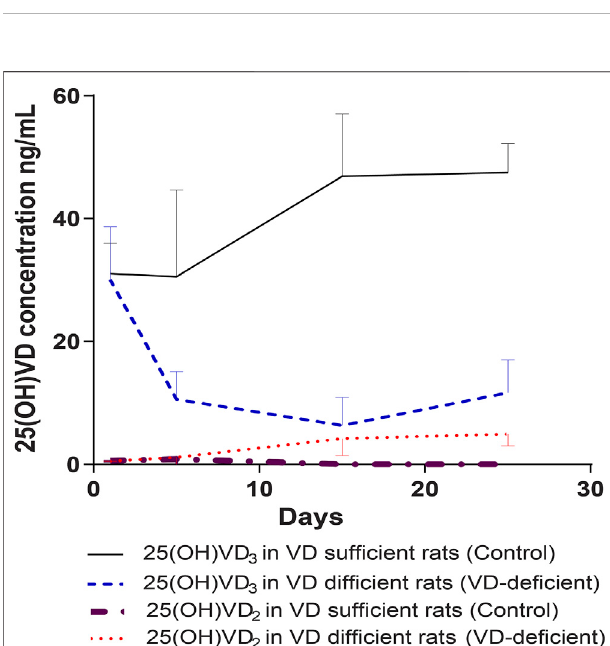
FIGURE 2 | Dynamic monitoring of plasma 25(OH)VD3 and 25(OH)VD2 inratsinpharmacodynamicstudy.Control:ratsfedonaVD-supplementhigh- fat diet for 25 – 30 days ( n = 14), plasma 25(OH)VD concentration is 20 – 100 ng/ml; VD-de fi cient: rats fed on a VD-free high-fat diet for 25 – 30 days ( n = 16), plasma 25(OH)VD concentration is < 20 ng/ml; Total 25(OH)VD: the total 25(OH)VD 2 and 25(OH)VD 3 concentrations in